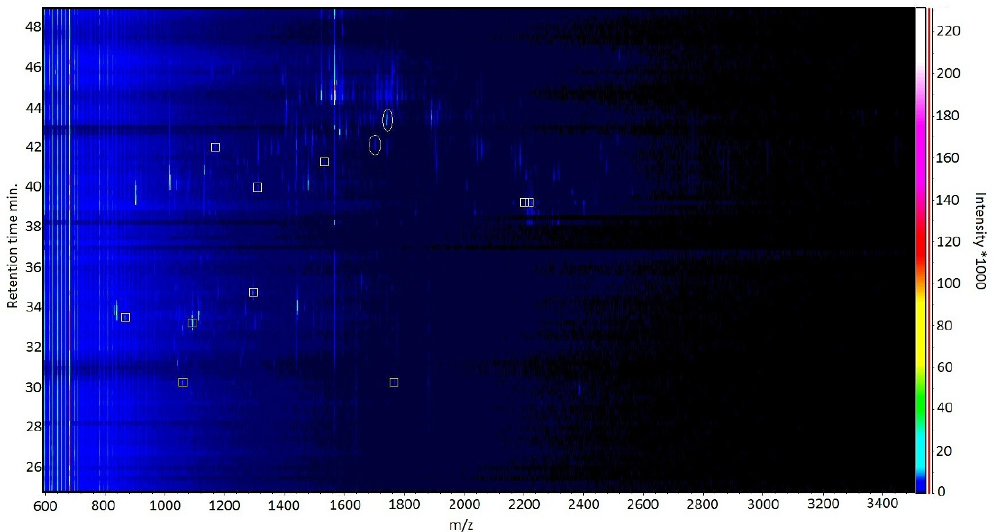
Figure 3. The record of the peptide separation from an unresolved spot (mixture vimentin and tubulin) after 2D SDS-PAGE hyphenated with nano HPLC, made by WARP-LC software (Bruker Daltonik,